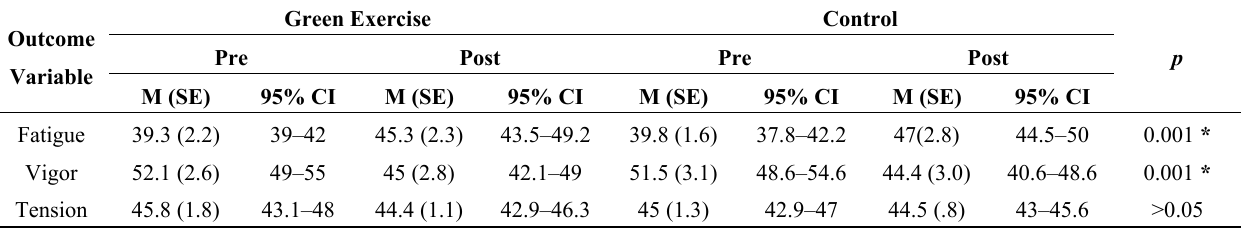
Table 2. Mean ± SE and 95% Confidence Intervals for fatigue, vigor and tension mood state scores, pre and 15 min post exercise in green exercise and control